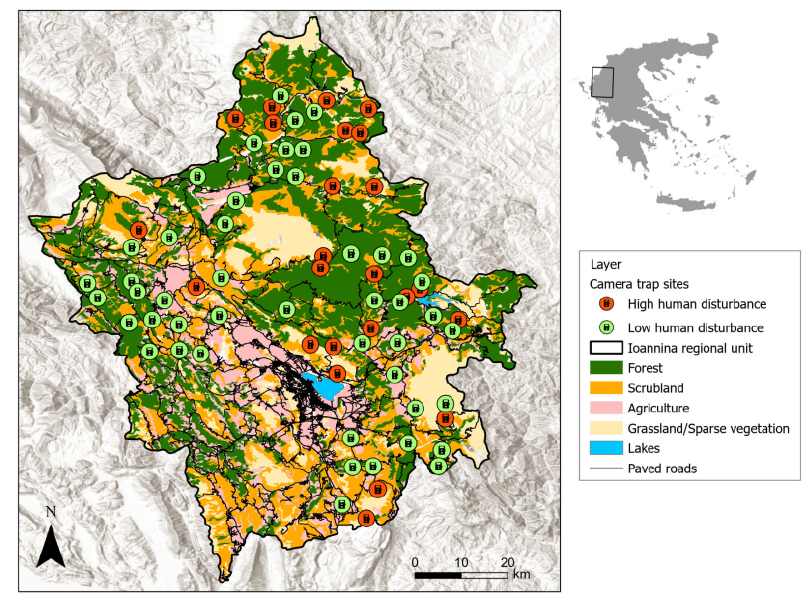
Figure 1. Map of the study area and locations of the 71 camera trap sites within the Ioannina regional unit, NW Greece, from July to October 2019 and July to November 2020. Red circles and green circles show camera stations that recorded high (n = 24) and low (n = 47) human disturbance, respectively (details in Section 2.3.3).